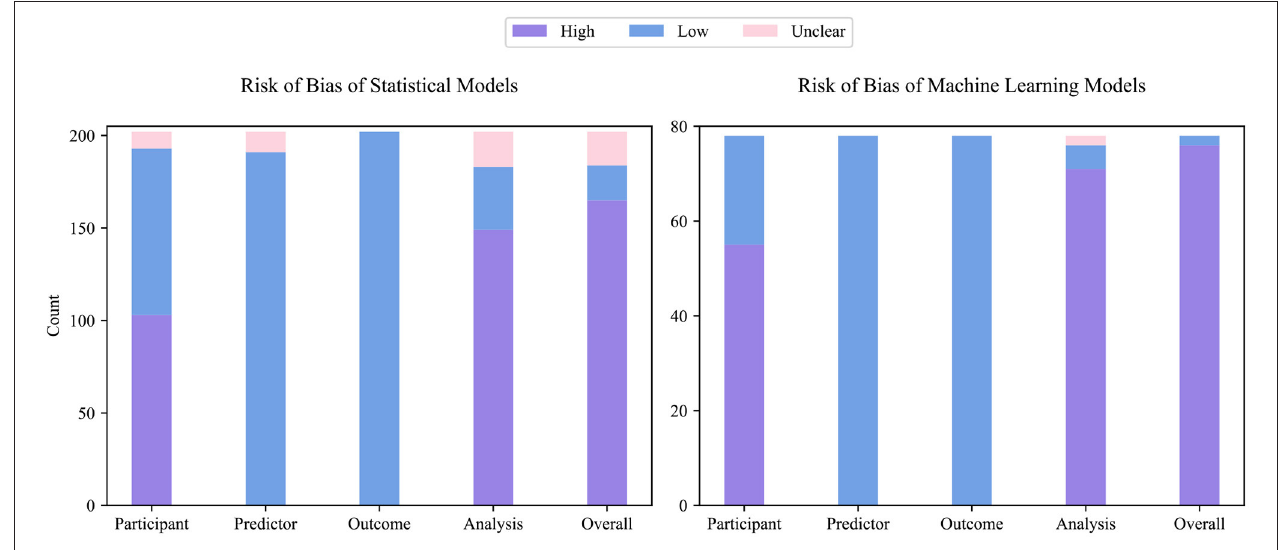
FIGURE 3 | Result of risk of bias